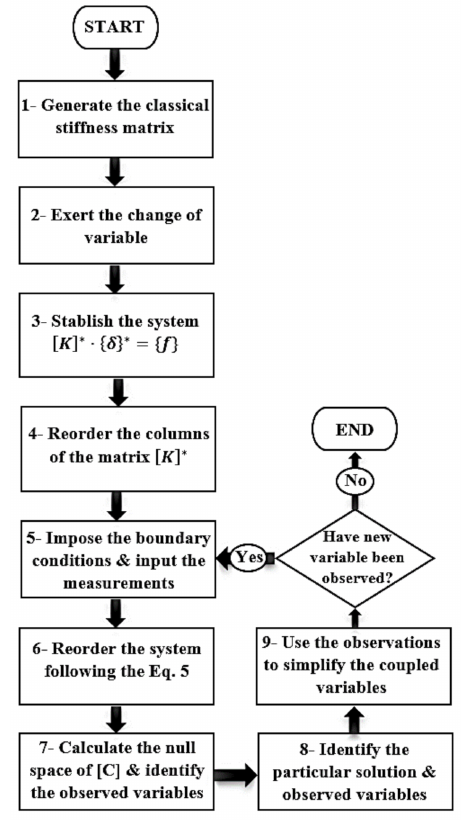
Figure 1. Flow chart of the algorithm.